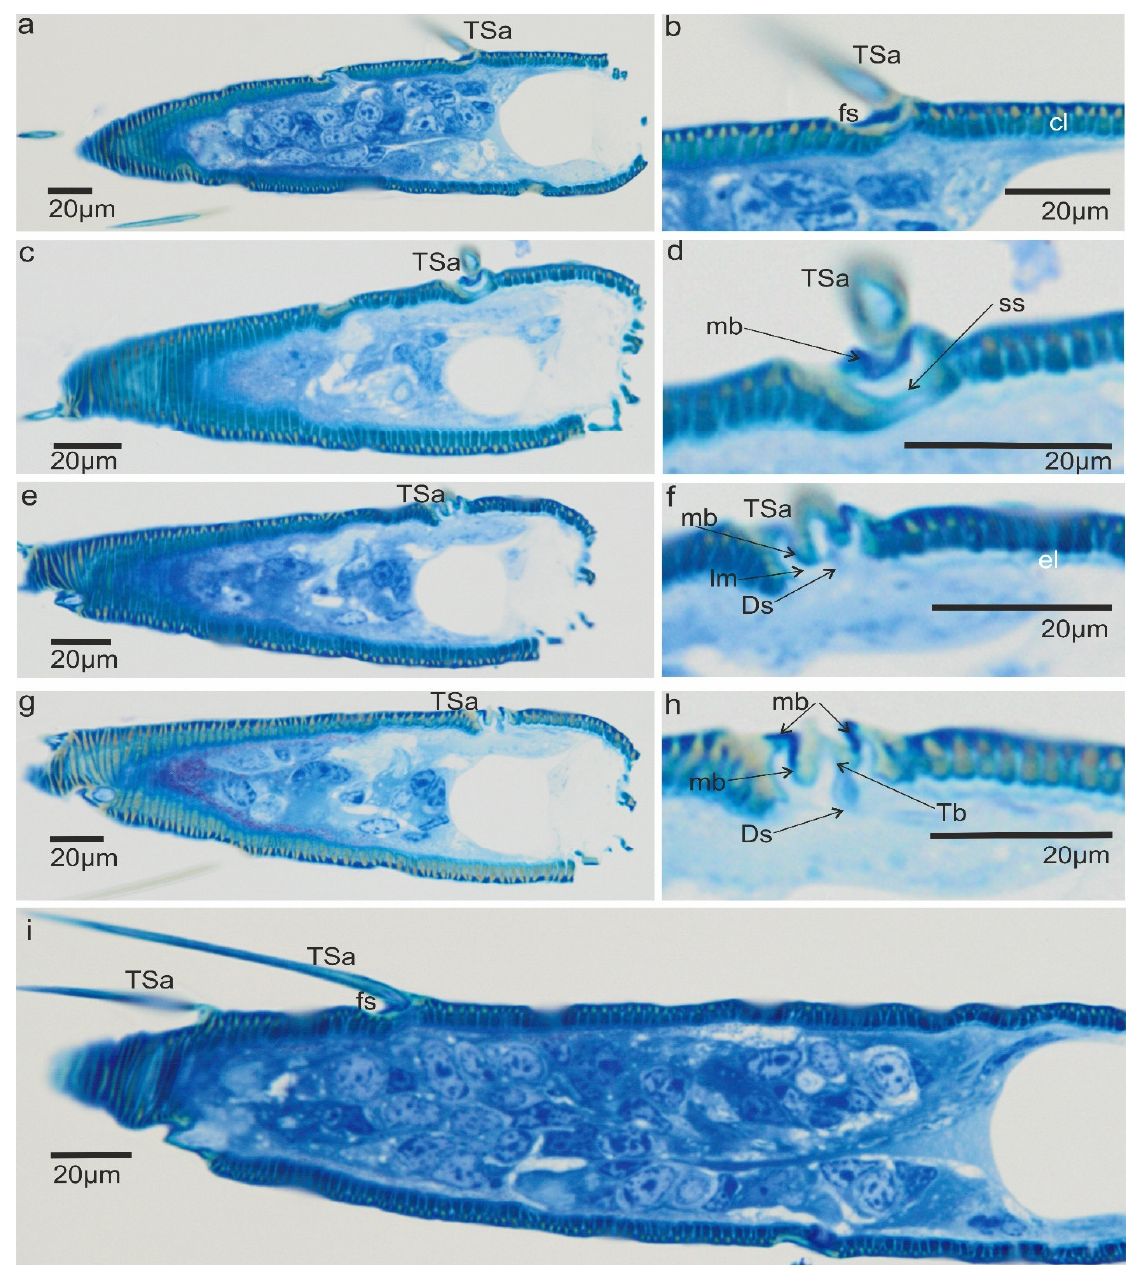
Figure 4. Microscopic photograph of the ultra-section of the flexible socket and termination of the tubular body of trichoideum sensillum in N. rugosus , longitudinal section by part of the pedicel: ( a , b ) trichoideum sensillum visible from the cuticular side; ( c , d ) further longitudinal section, with the shape of the socket and membrane visible in the deeper layer of the cuticle; ( e , f ) inner side of the socket and lymph cavity (lm) and part of the dendrite of the mechanoreceptor; ( g , h ) dendritic way (Ds) and tubular body terminated at the base of the trichoideum sensillum; ( i ) magnification of the other trichoid sensilla and the base of the sensillum in the socket. Cl, cuticular layer; f, flexible socket (fs) in trichoideum sensillum (TSa); el, epidermal layer; mb, socket membrane; ss, socket septum. 3.3. Ultrastructures of Trichoid Mechanosensillum Using TEM In the longitudinal section (Figure 5a,b), the socket membrane (mb), suspension fibre (sf), and socket septum (ss) are documented in the ultrathin slides.